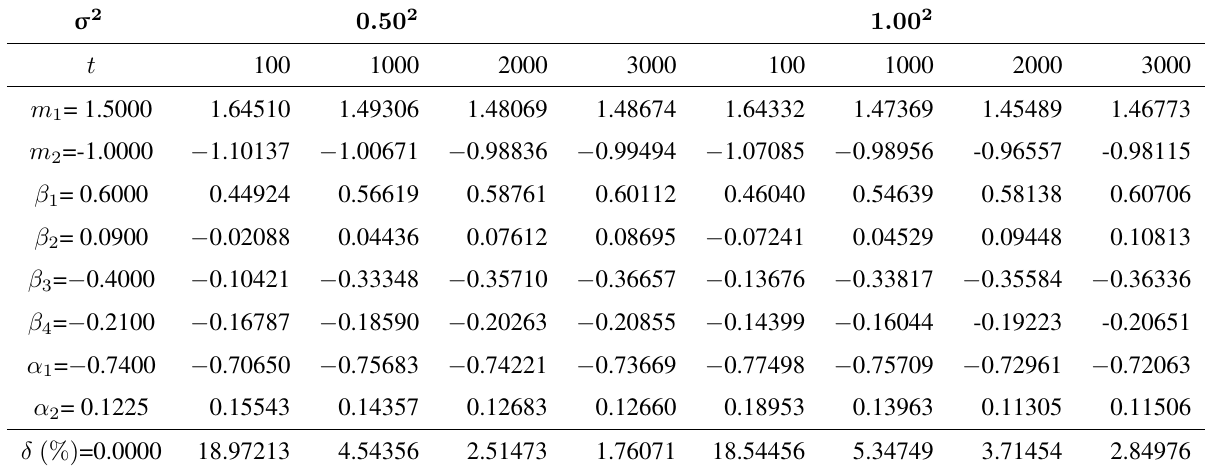
Table 1. The dual-rate parameter estimates and errors.